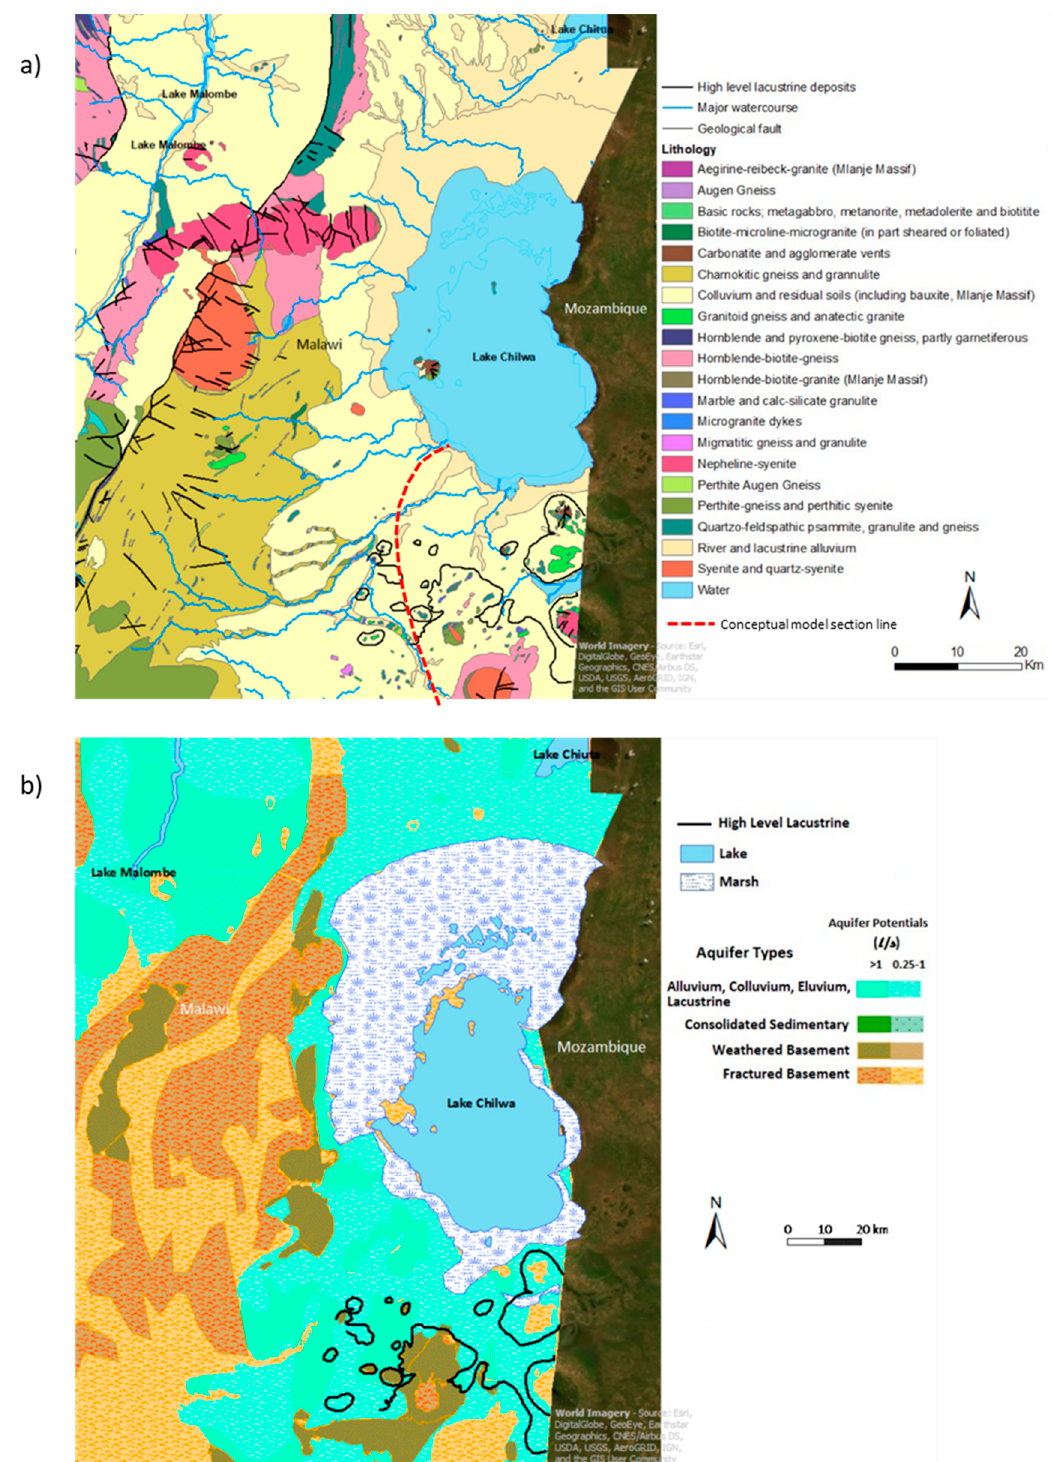
Figure 2. Lake Chilwa Basin WRA 2 study area: ( a ) Solid and superficial deposit geology (digitized, adapted and reinterpreted from Garson and Walshaw [31]); ( b ) classification of aquifer types (adapted from the Malawi hydrogeological and water quality 1:650,000 Map (2018) produced by the Council for Geoscience, Republic of South Africa (publ. Gov’t of Malawi, MoAIWD National Water Development and Shire River Basin Management Programmes).